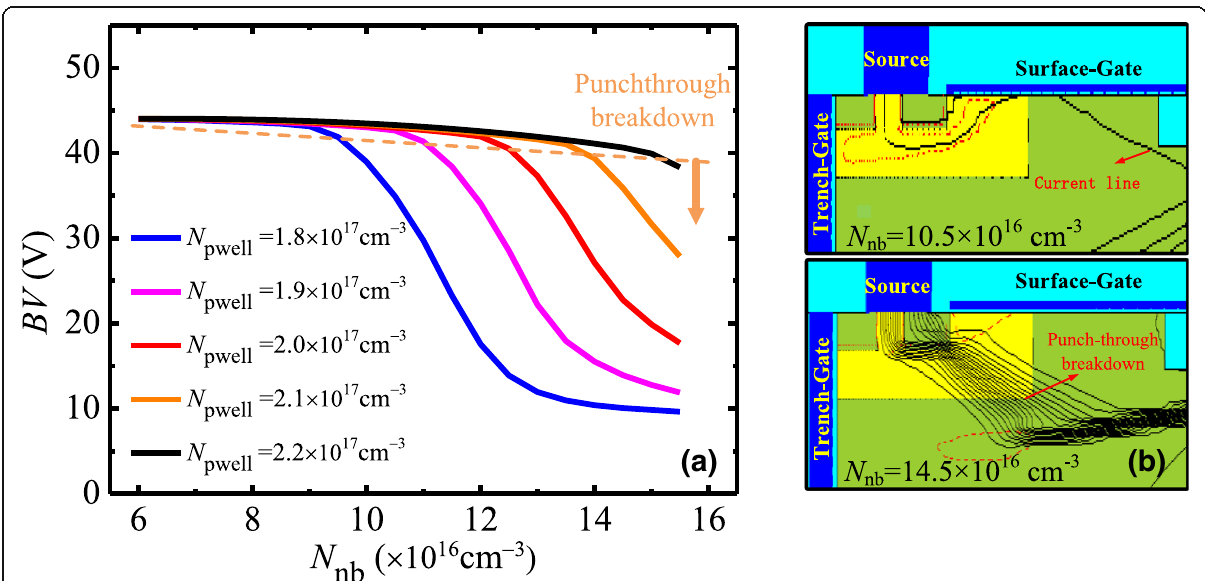
Fig. 3 a Numerical BV as a function of N nb with different N pwell . b Current density profile for N nb = 10.5 × 10 16 cm − 3 and 14.5 × 10 16 cm − 3 while N 17 cm − 3 at pwell = 2 × 10